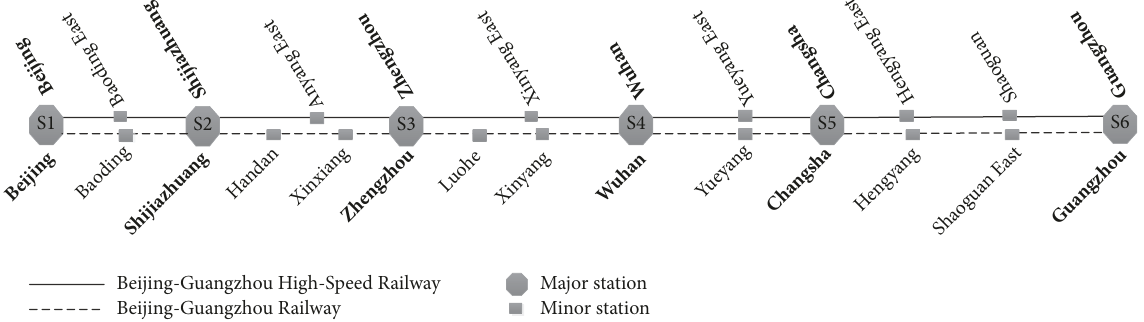
Figure 6: Topological relations of Beijing-Guangzhou High-Speed Railway and Beijing-Guangzhou